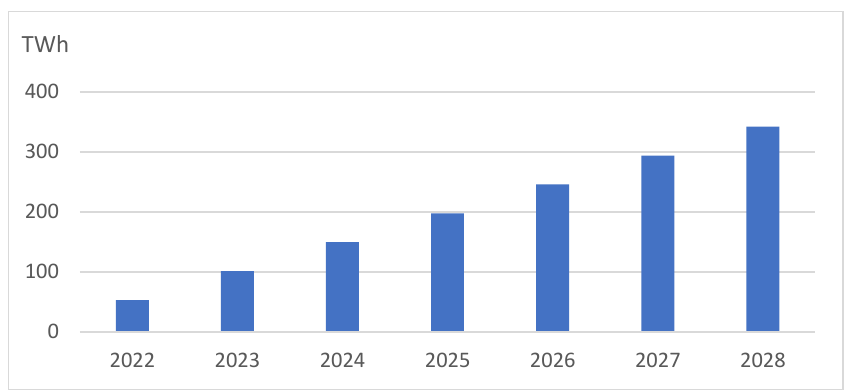
Figure 8. Additional electrical energy obtained from renewable sources until 2028. Source: own elab- orations.